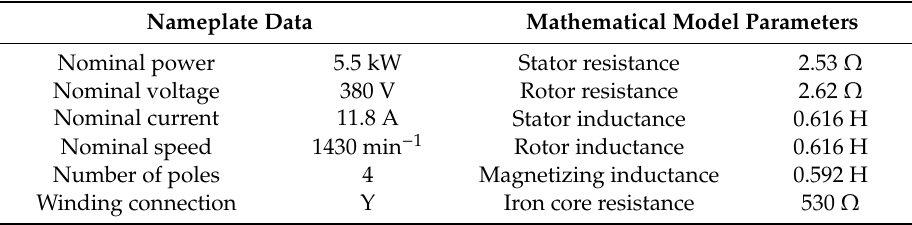
Table A1. Induction motor parameters.